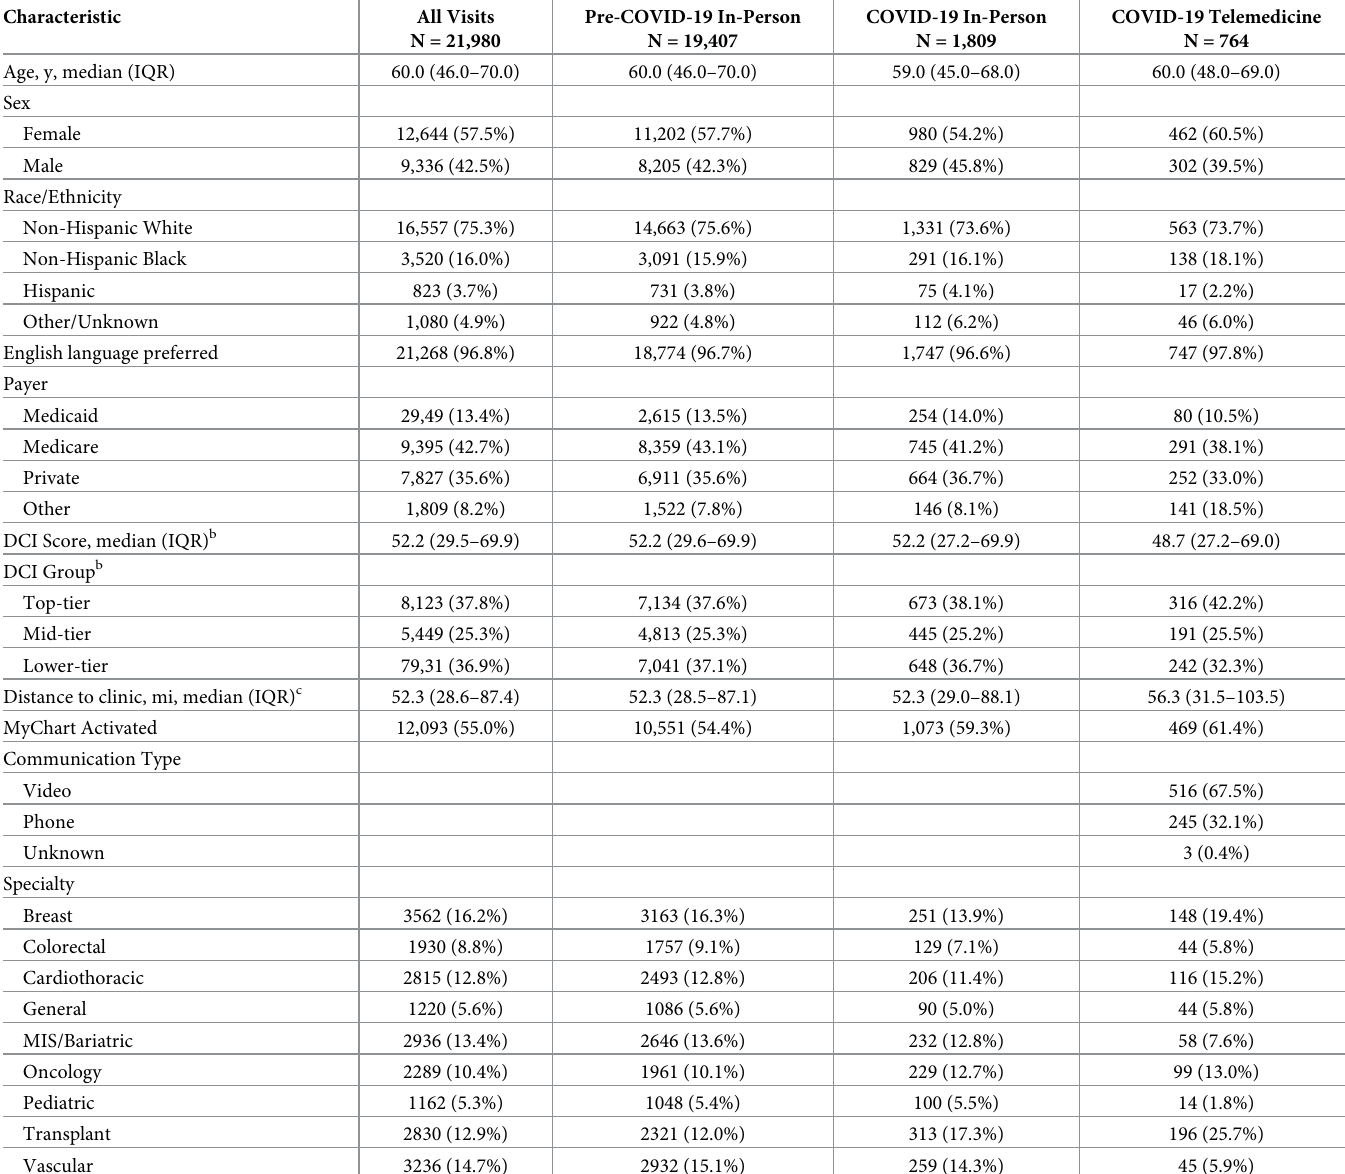
Table 1. Patient characteristics by visit type a